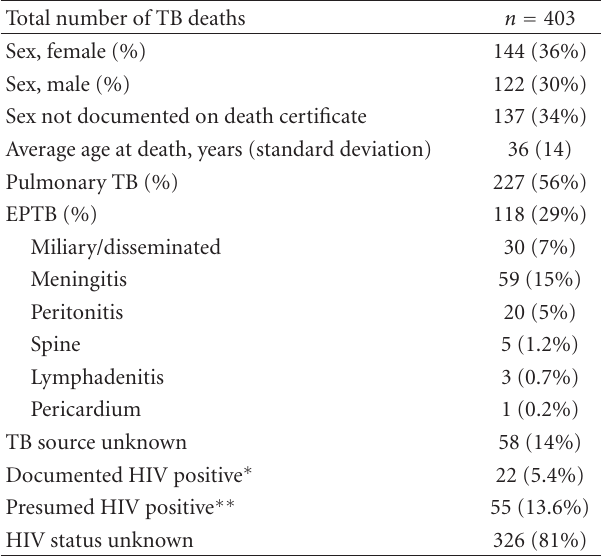
Table 1: Clinical and demographic